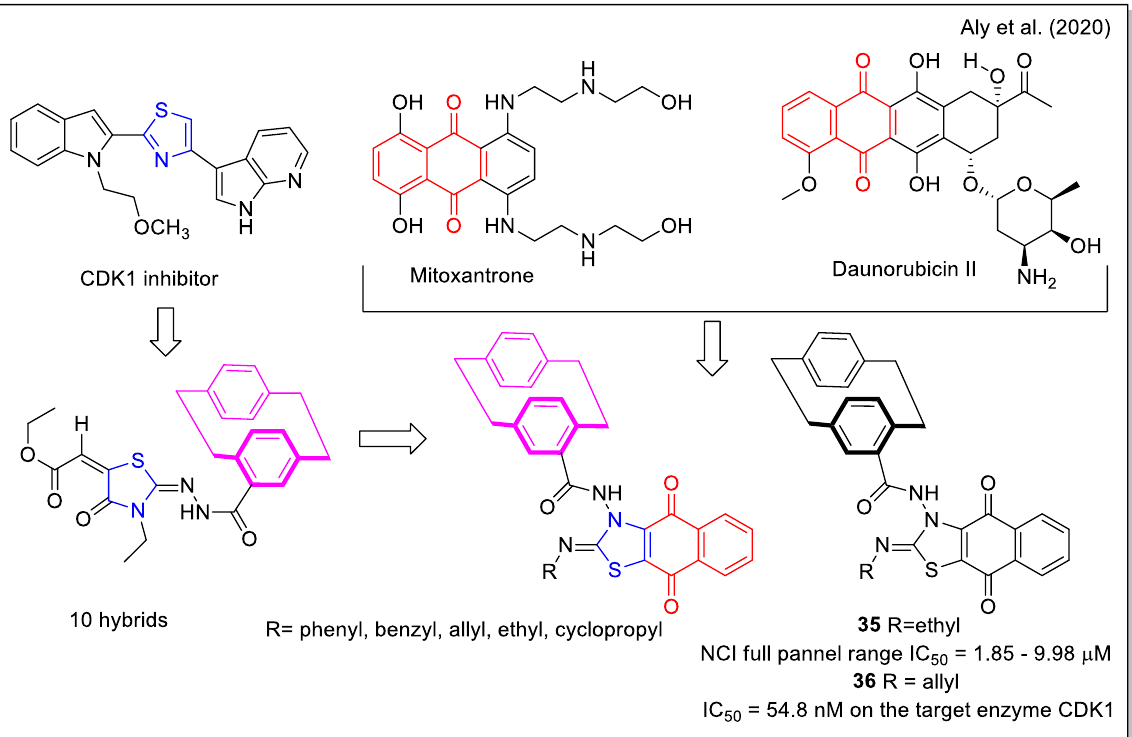
Figure 14. 1,4-Naphthoquine-thiazole-paracyclophane hybrids as reported by Aly et al. [47]. Figure 15. Steroid-anthraquinone hybrids as reported by De Riccardis et al.